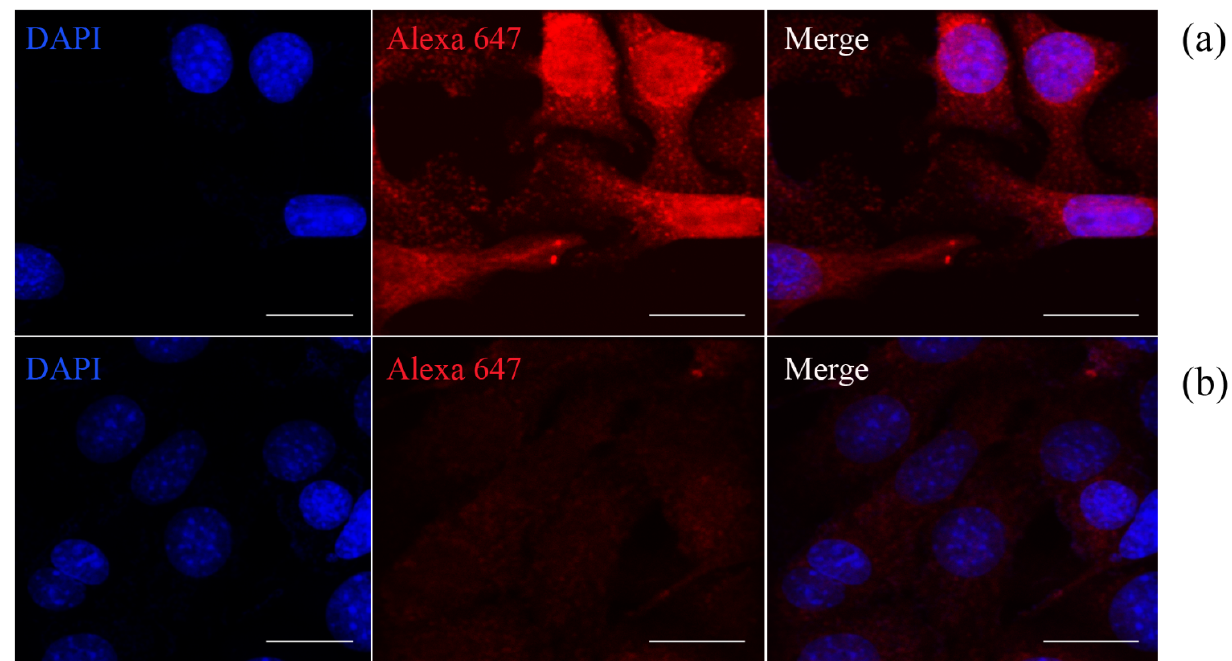
Figure 2. 4T1-Qt ( a ) and 4T1 ( b ) cells stained with Alexa Fluor 647 anti-DYKDDDDK Tag antibody (red fluorescence). Nuclei were counterstained with DAPI (blue fluorescence). Laser scanning confocal microscopy, scale bar 20 µm.